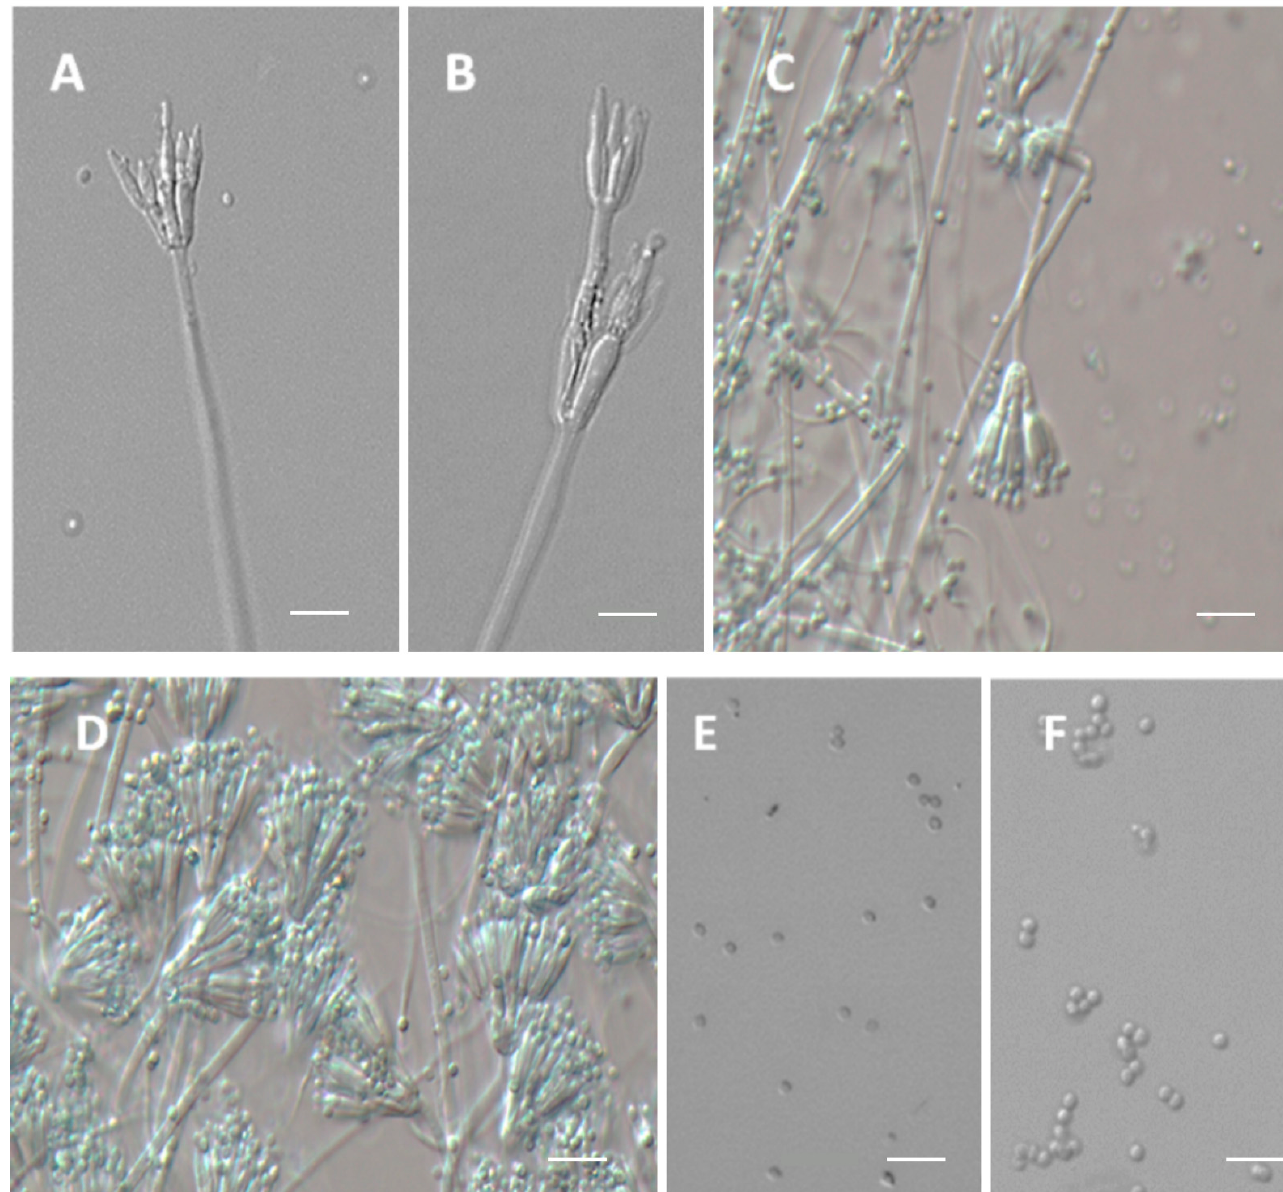
Figure 3. ( A – D ) Monoverticillate and Biverticillate Conidiophores. ( E , F ) Conidia. Scale bars = 10 µm.